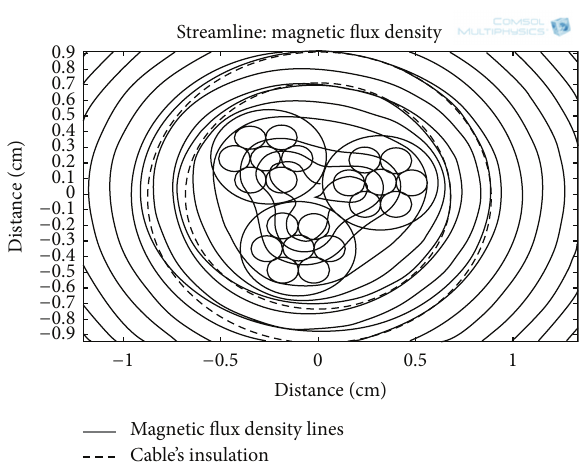
Figure 9: MFD lines along a cross-section of a three-core cable at a current level of 72